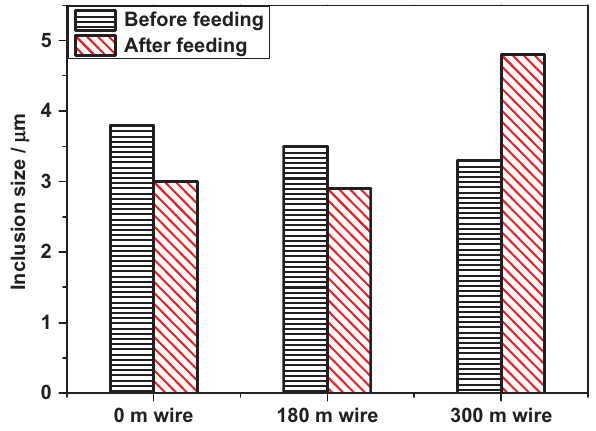
Figure 7: Effect of CaSi wire length on the size of inclusions.